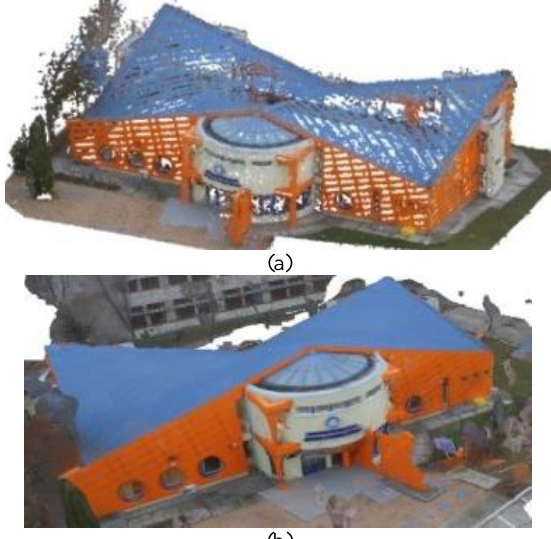
Figure 3. The „Dean’s office” building model, created in the Zefhyr software based on UAS images point cloud (a), mesh surface